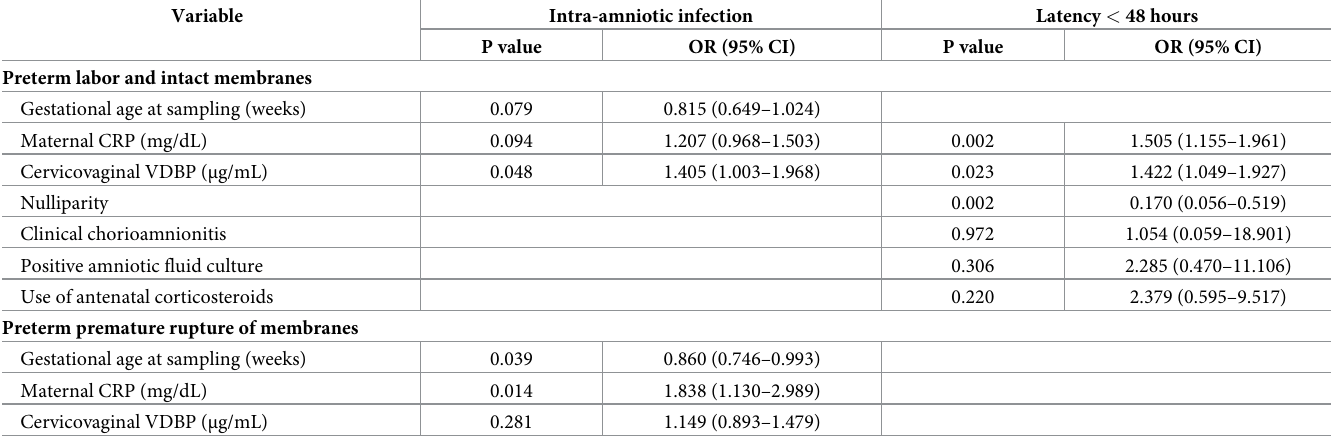
Table 4. Association between cervicovaginal vitamin D-binding protein and risks of intra-amniotic infection and delivery within 48 hours, as determined by logistic regression analyses in women with preterm labor and preterm premature rupture of